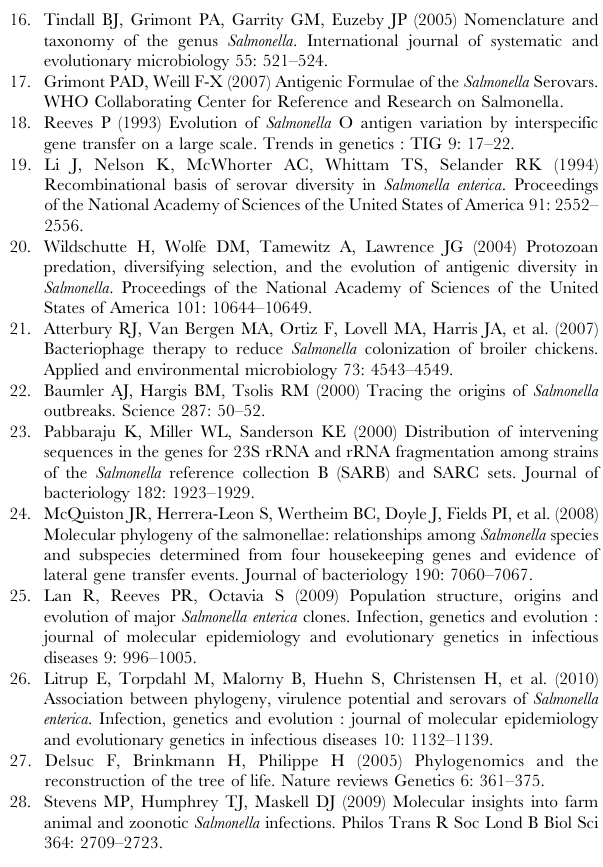
Figure S7 FimH alleles in Salmonella subspecies I. Available genomic and protein sequence data identified 67 FimH alleles in Salmonella subspecies I. The alleles were divided in six groups (1 to 6, on the left) based on a FimH average distance tree produced by using BLOSUM62. The top two rows list the substituted FimH residue positions with the most prevalent residue at this position. The background for the lectin domain residues is labeled in dark gray, whereas the background of the pili domain residues is labeled in light gray (linker domain in white). Residue positions in red correspond to mannose-binding enhancing substitutions and residue positions in green correspond to mannose-binding neutral substitutions; residue substitution effects on mannose binding in other positions is not known. Table S1 FGCs of two strains of E. coli and their orthologous FGCs in Salmonella . Table S2 Salmonella FGCs and characteristics supportive of past HGT for some FGCs. Table S3 Genes of each FGC and known functional phenotypes. Known or predicted adhesin genes are shown in red. Table S4 Variation of Salmonella fimbrial core (red), conserved (green) and sporadic (blue) adhesin genes (or predicted adhesin genes).